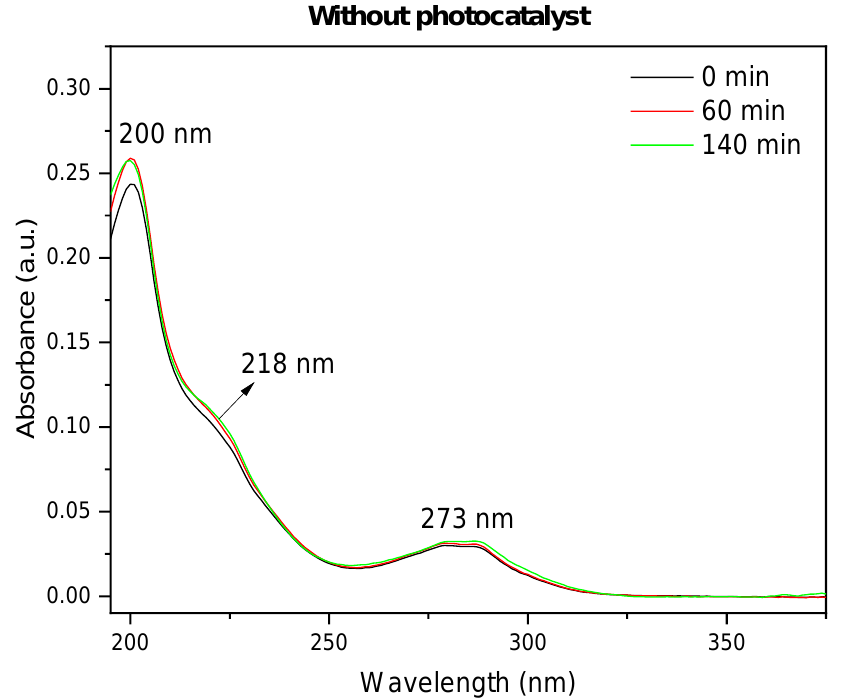
mechanical stirring, in the absence of UV Figure 12. Absorption spectra of fipronil (Ci = 3370 µg L −1 ) in the absence of Zn-AlPO 4 , under me- chanical stirring, in the absence of UV radiation.